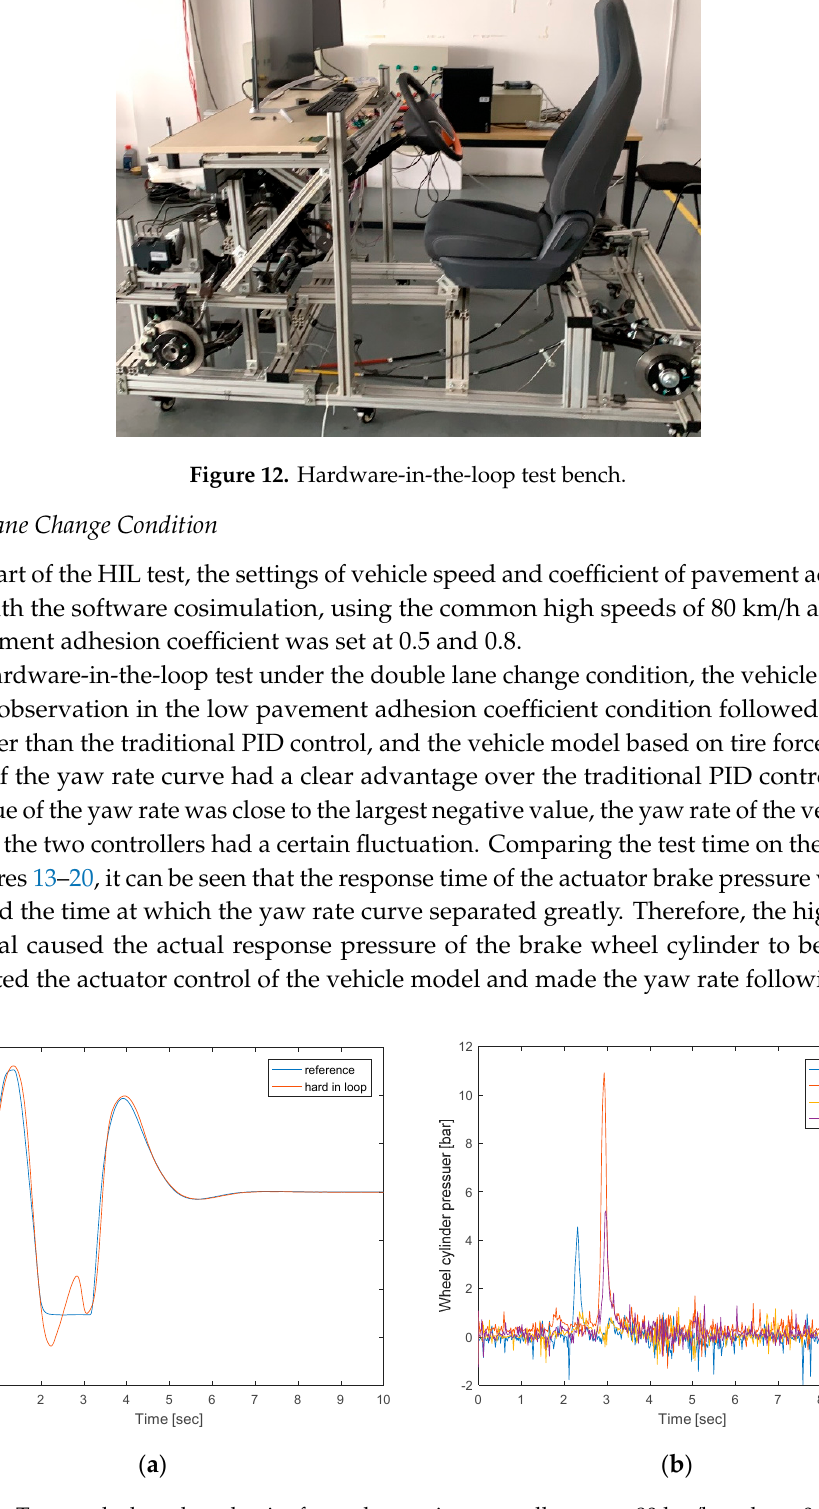
Figure 13. Test results based on the tire force observation controller at u = 80 km / h and µ = 0.5. ( a ) is a comparison of the nominal and actual values of the yaw rate, and ( b ) is the wheel cylinder pressure value collected from the wheel cylinder pressure